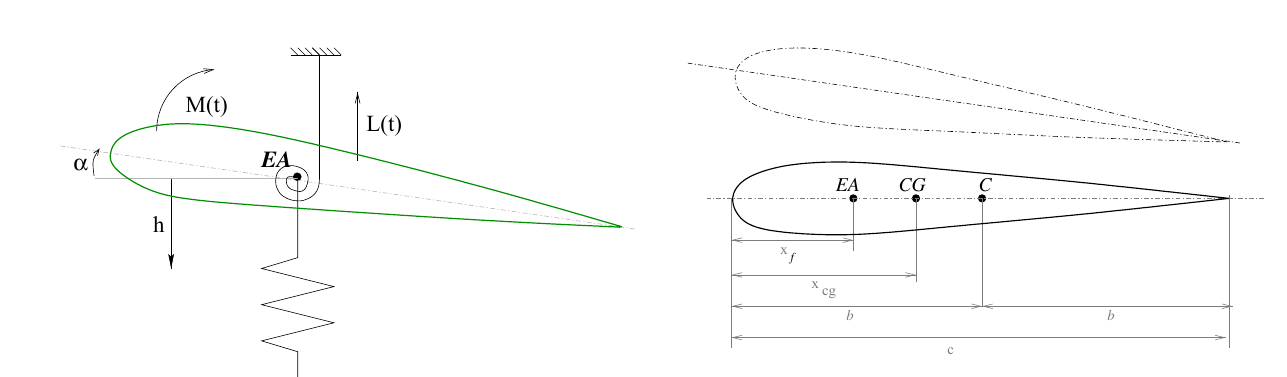
Fig. 2. Elastically supported airfoil with two degrees of freedom bending h and pitching α (on the left). Airfoil in undeformed position showing the elastic axis (EA) and center of gravity (CG) (on the